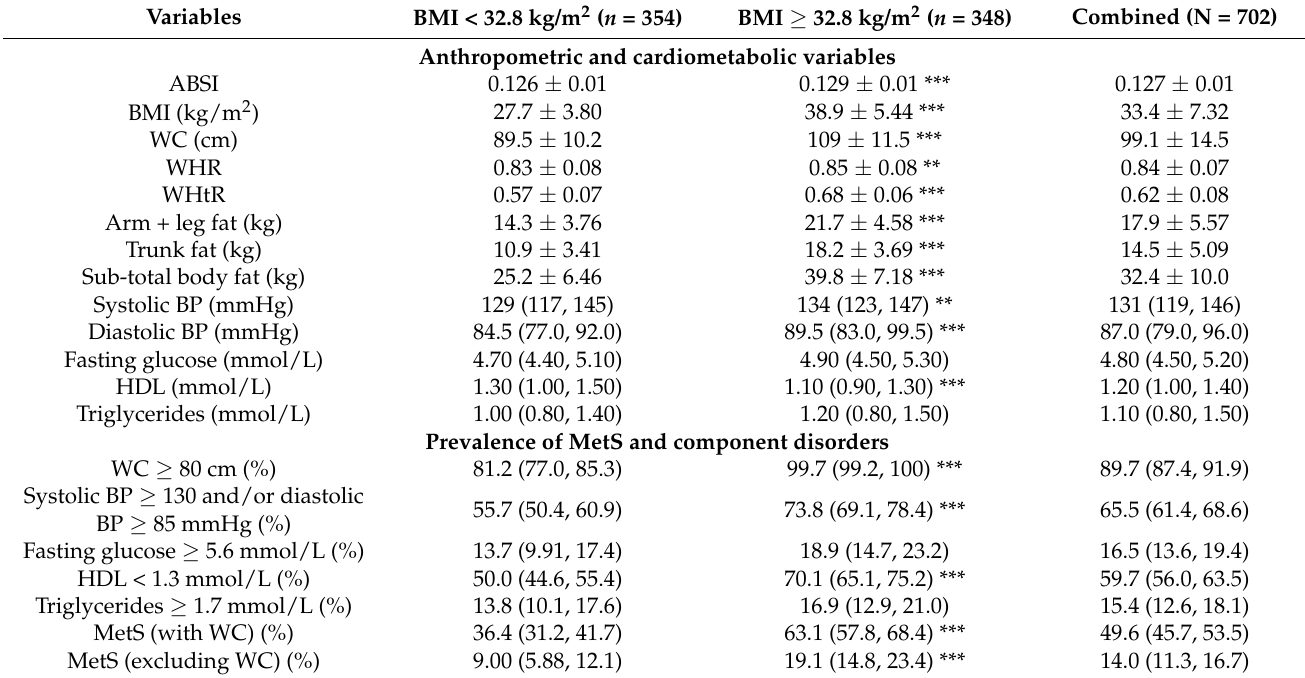
Table 1. Subject characteristics stratified by the median BMI and for the whole cohort.